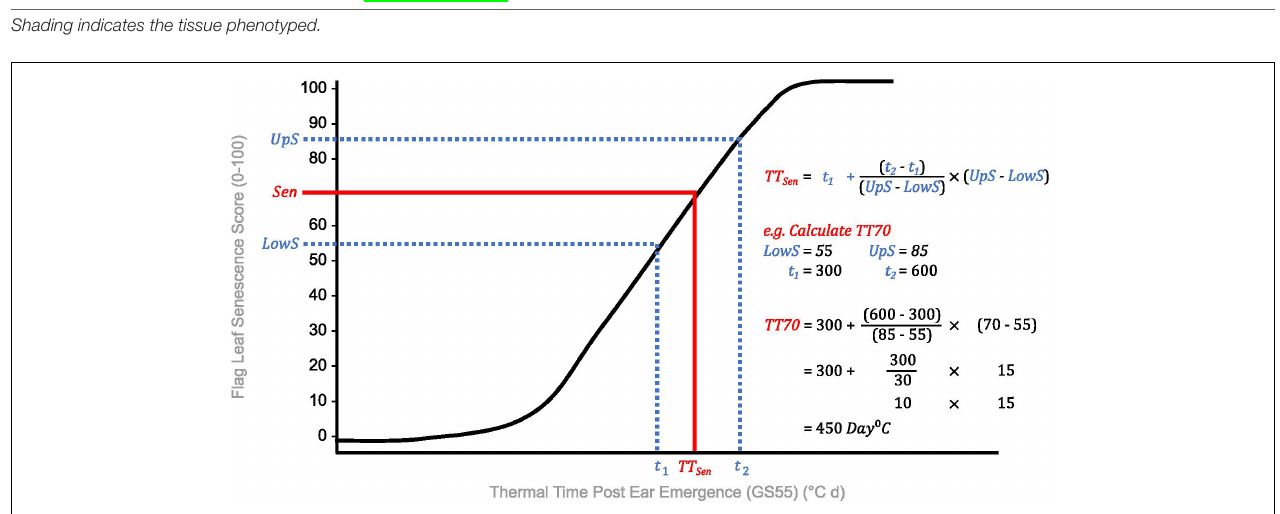
FIGURE 4 | Calculation of thermal time to flag leaf senescence score of 70 (TT70), a dynamic senescence metric. Senescence scoring dates are converted into thermal time from ear emergence ( ◦ C d) to standardize for heading date variation. A “target” flag leaf senescence score is specified (Sen), and time points for scores below ( t 1 , LowS) and above ( t 2 , UpS) this are identified. Assuming senescence progresses linearly, time elapsed between flag leaf senescence scores is divided proportionately to estimate the time to the target score (TT Sen ).